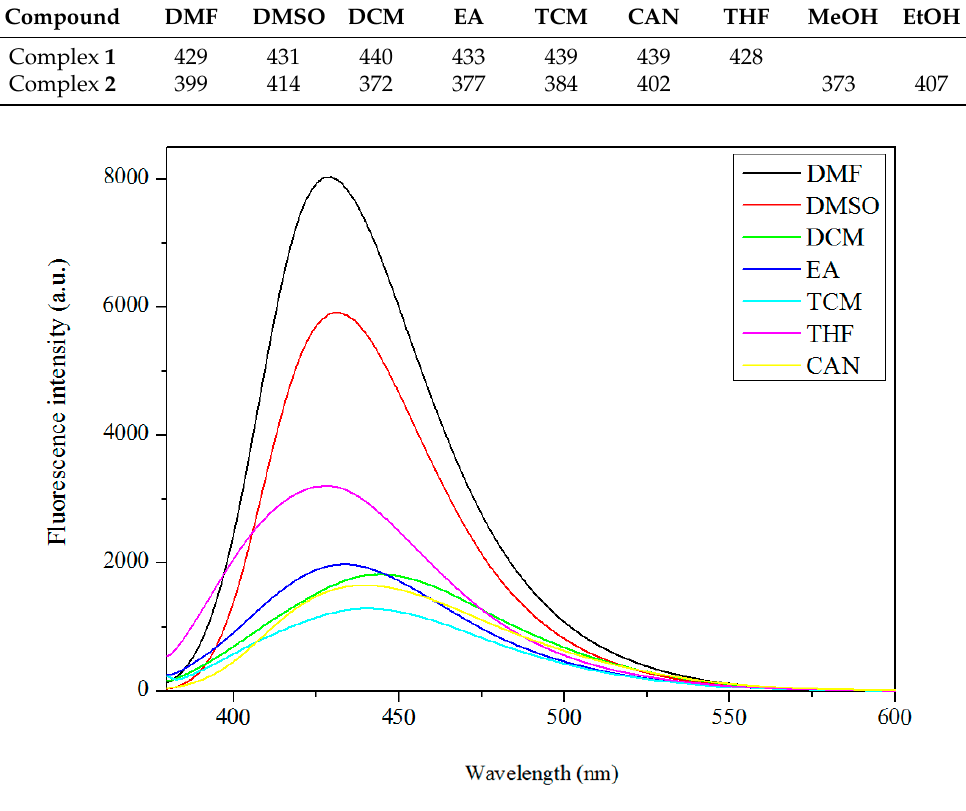
Figure 10. The fluorescent ( λ ex = 370 nm) spectra of complex 1 (2.5 × 10 − 5 M) in various solvents.